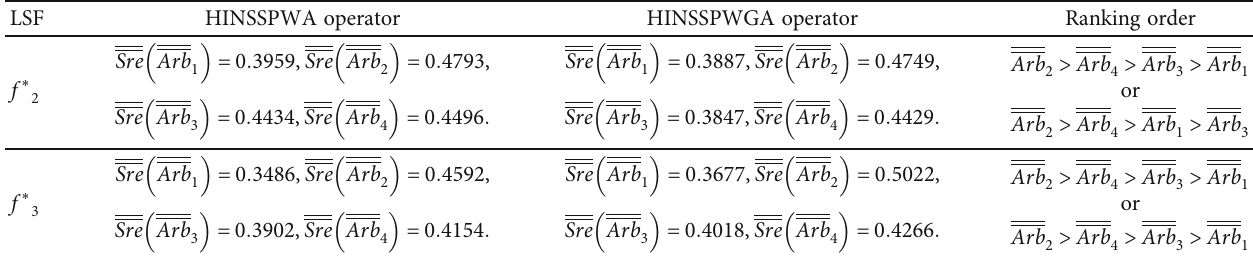
Table 2: Score values and ranking orders of alternatives utilizing di ff erent